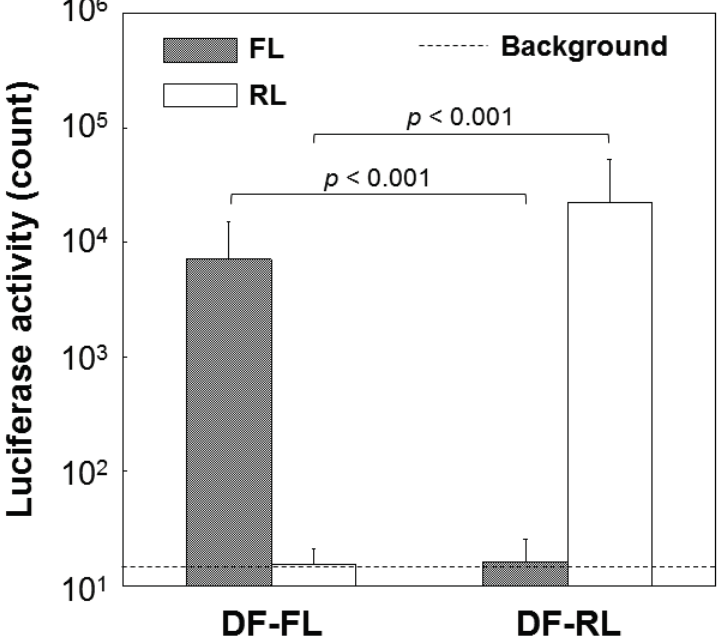
Figure 5. Luciferase (firefly luciferase (FL) and Renilla luciferase (RL)) activity in CHO-K1 cells cultured on the DNA–fibronectin–apatite composite layers (DF-Ap layers) immobilizing FL gene (Sample FL) and RL gene (Sample DF-RL). Both Samples FL